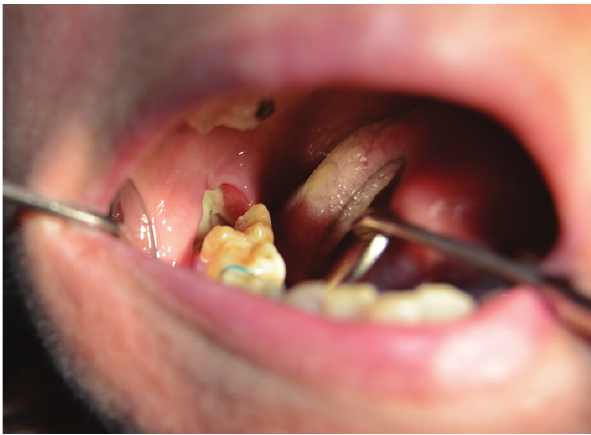
Figure 3: Intraoral view of sequestrectomy.